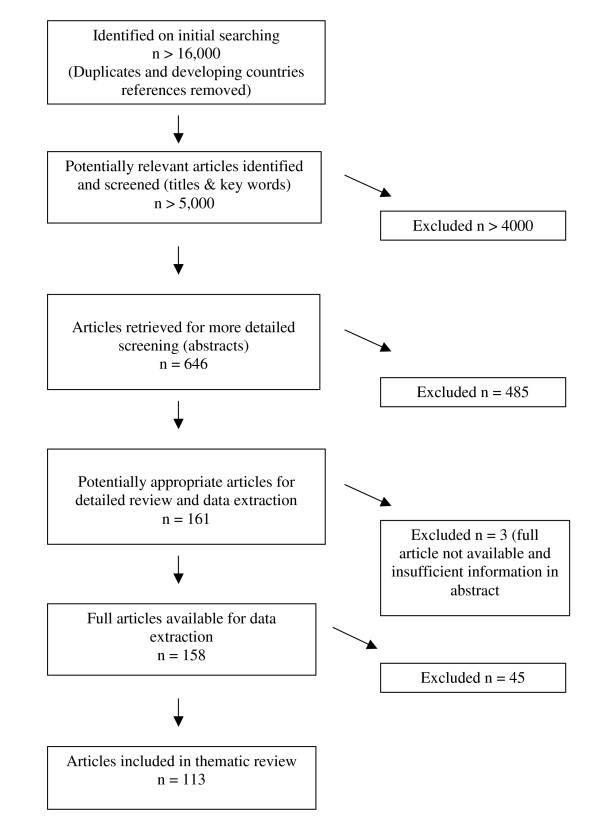
Selection process of eligible studies.